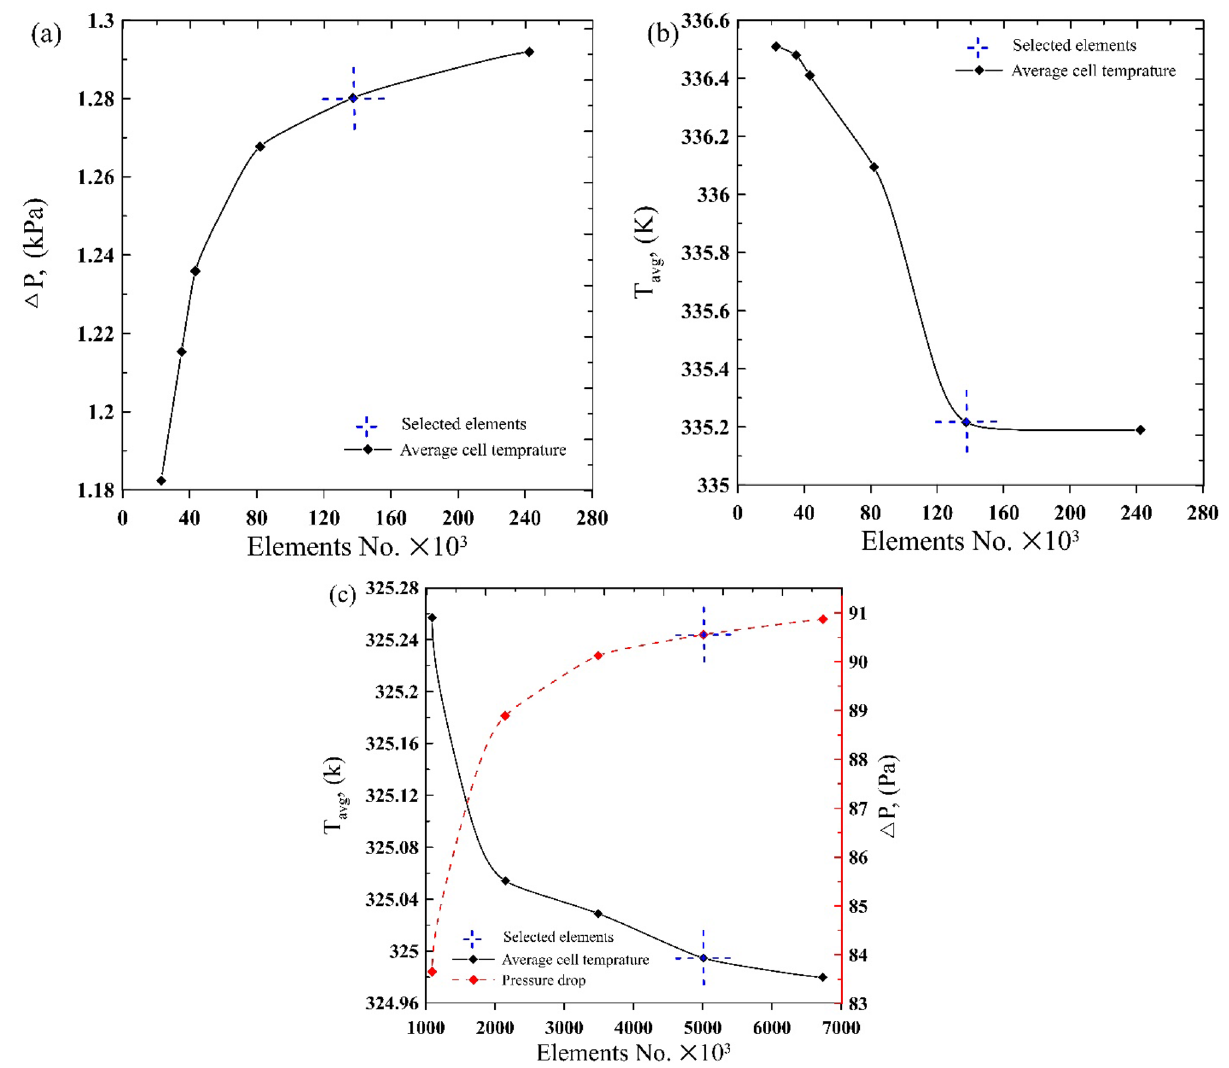
Figure 4. Mesh independence test for ( a , b ) 2D divergent microchannel without header, ( c ) CPV/T